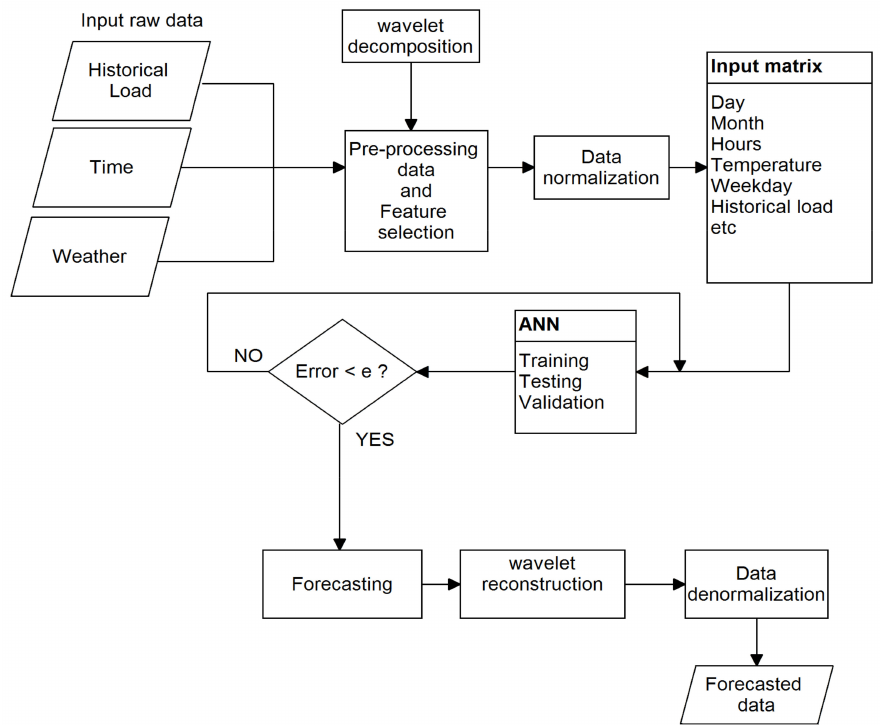
Figure 8. Proposed WANN model